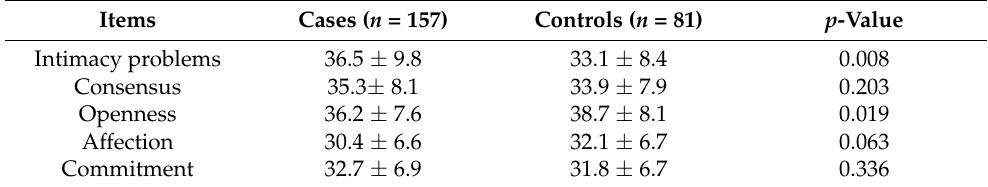
Table 5. Comparison of MIQ survey results between women with thrombophilia and recurrent pregnancy loss (cases), women with thrombophilia and recurrent pregnancy loss who achieved a normal pregnancy, and preterm or full-term birth (controls).